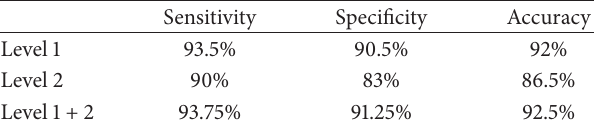
Table 1: Results obtained using the proposed feature in R channel.